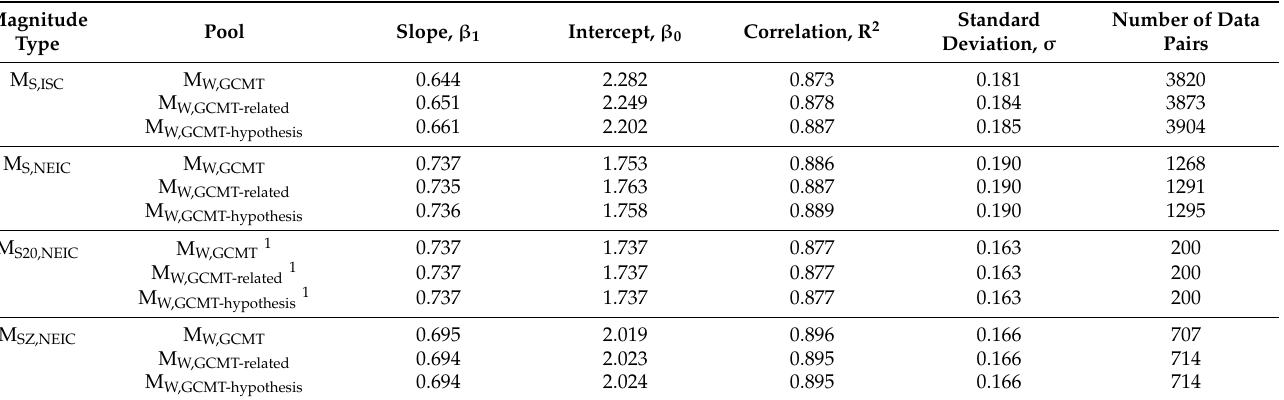
Table 4. Magnitude homogenization regression results from all moment magnitude pools for surface wave magnitude types.